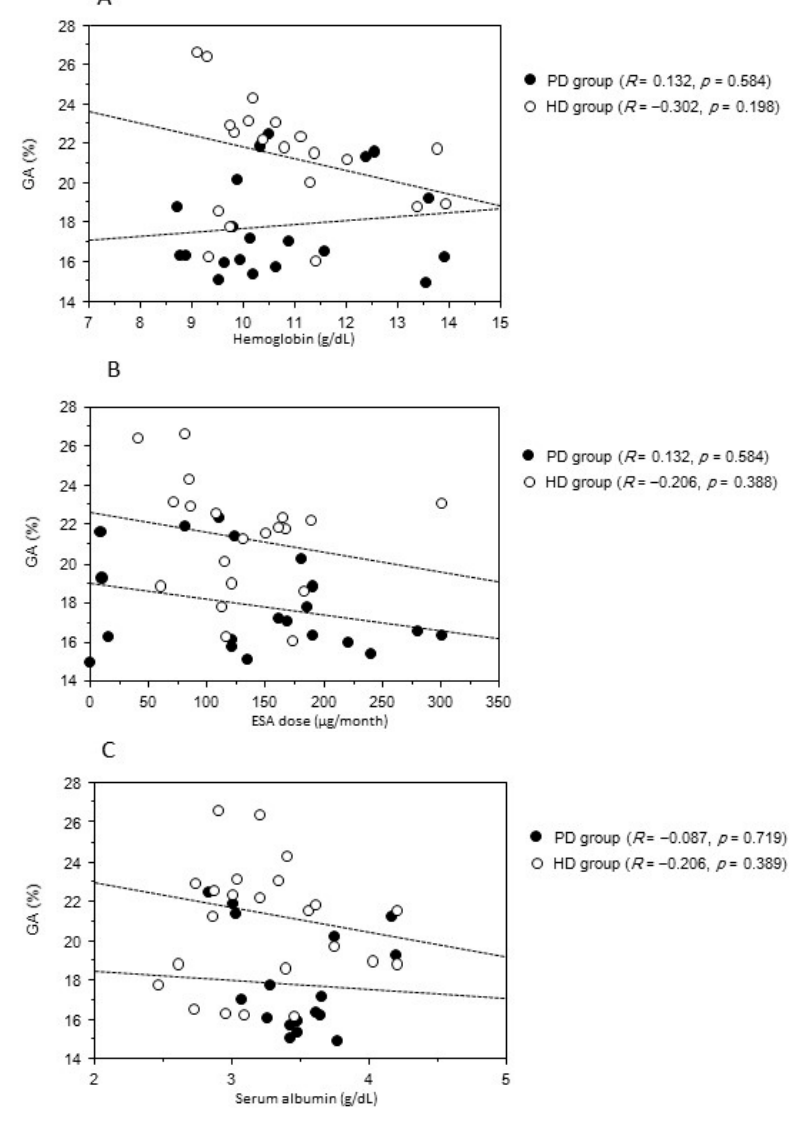
Figure 4. Cont. Figure 4.